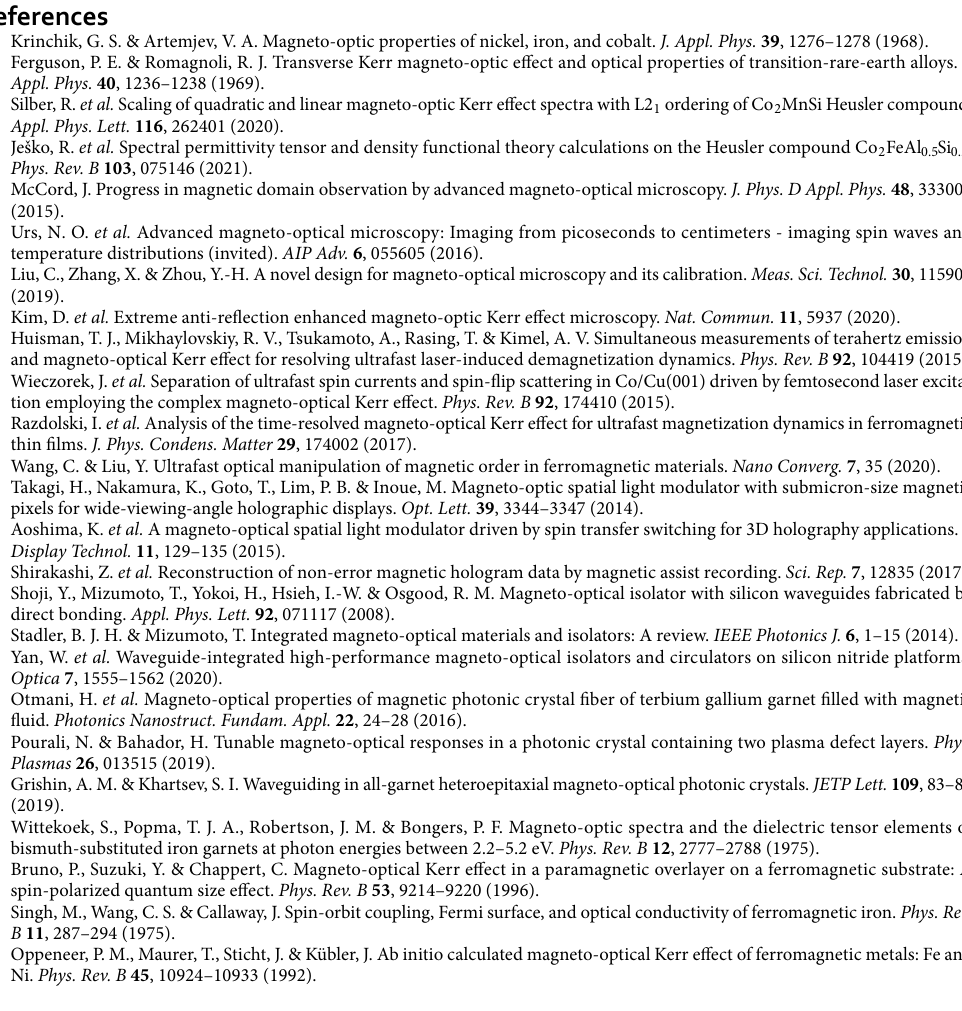
direction as parallel and perpendicular. The strongest signal to the MO spectra is provided by two-dimensional parallel transitions. We also present several possibilities of enhancing the MO signal (Fig. 9) by an appropriate band structure engineering.